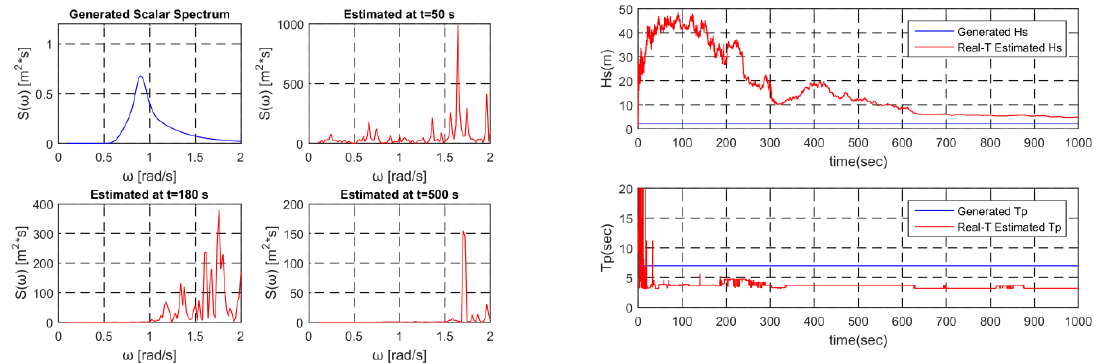
Figure 10. Generated and estimated spectrum / Evolution of parameters using six motion (Hs = 2 m, Tp = 7 s, Frequence: 0.1~2.0 rad/s).